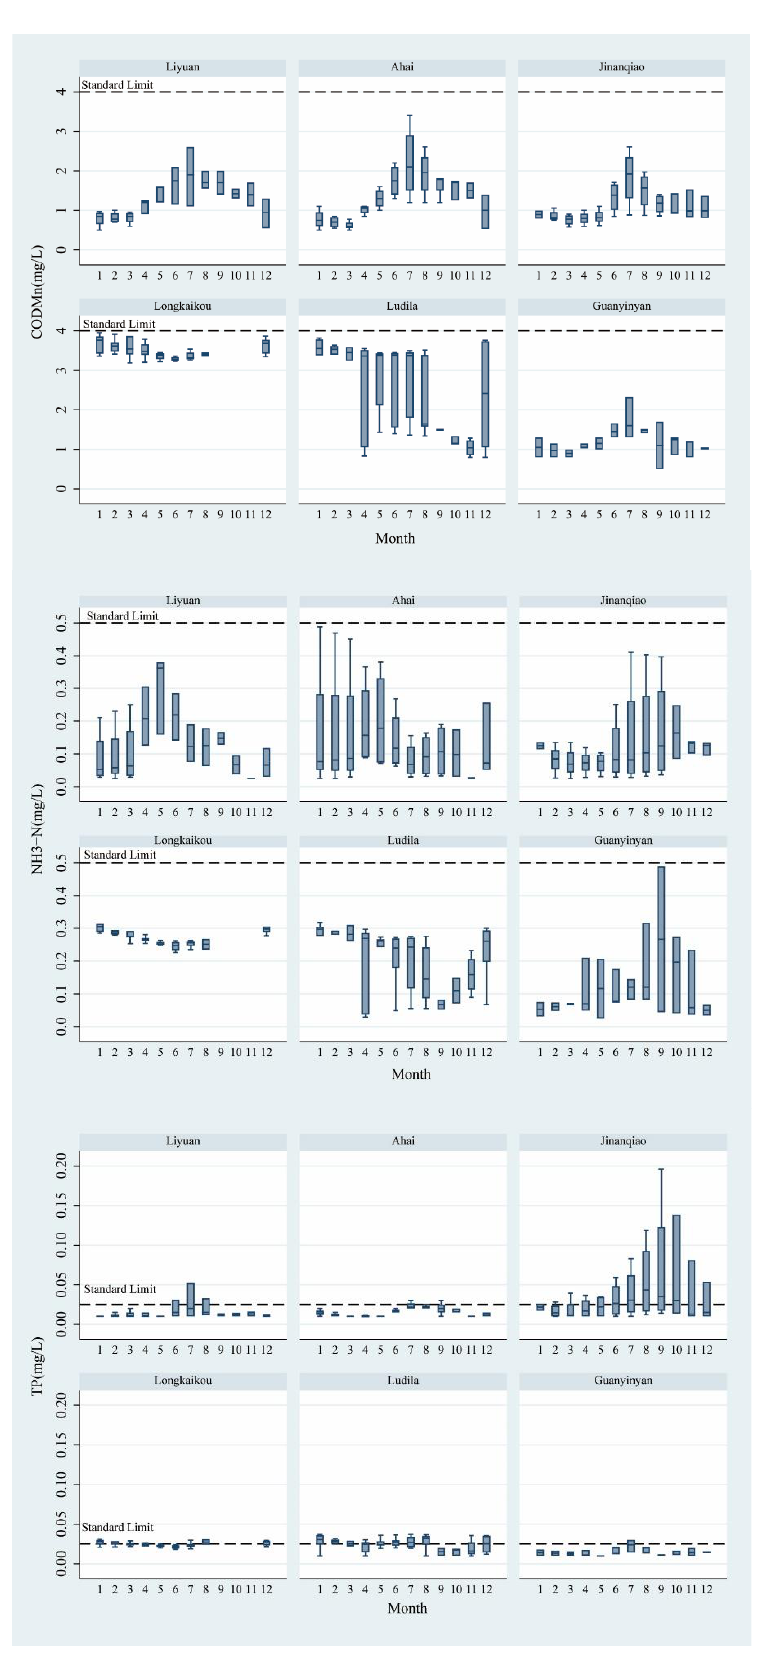
Figure 4. Boxplot of monthly changes in pollutant concentrations at each cascade hydropower station after hydropower development on the middle reach of the Jinsha River.